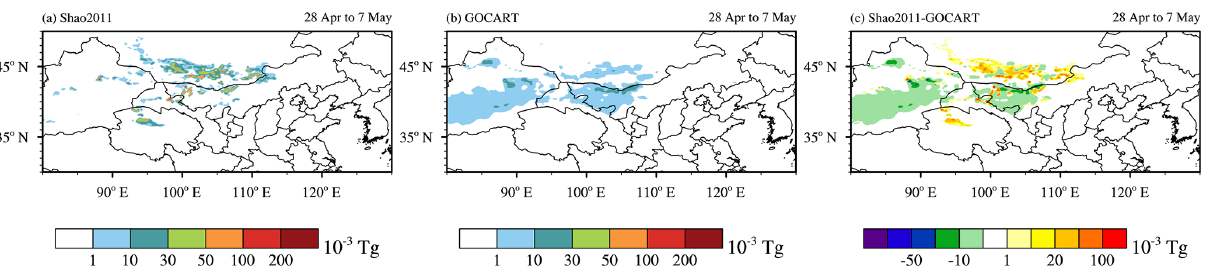
Figure 4. The simulated total dust emission (10 − 3 Tg) from two dust emission schemes: (a) Shao2011 and (b) GOCART from 00:00UTC on 28 April to 23:00UTC on 7 May 2017. (c) The total dust emission flux difference between Shao2011 and GOCART. The diameter of the emitted dust is less than 10µm in both GOCART and Shao2011 dust emission